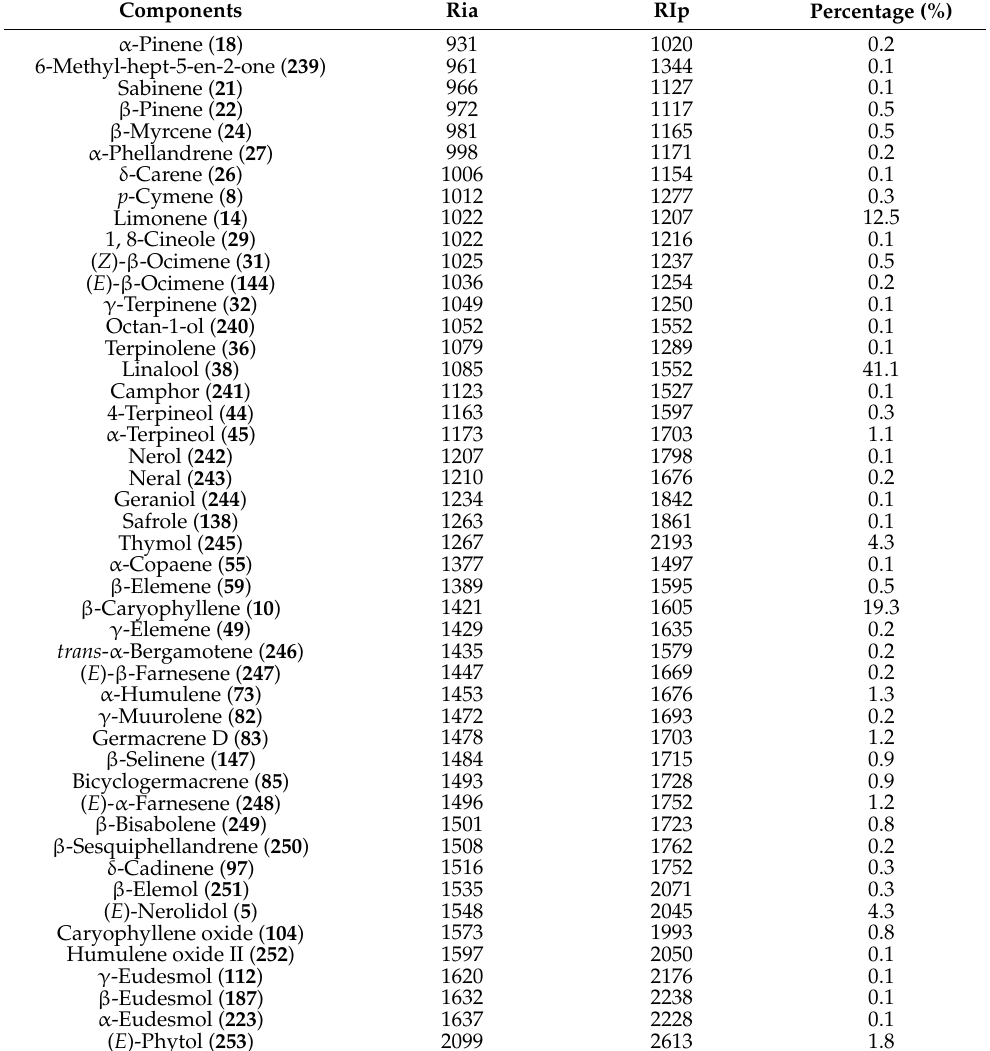
Table 8. List of essential oil of P. umbellatum